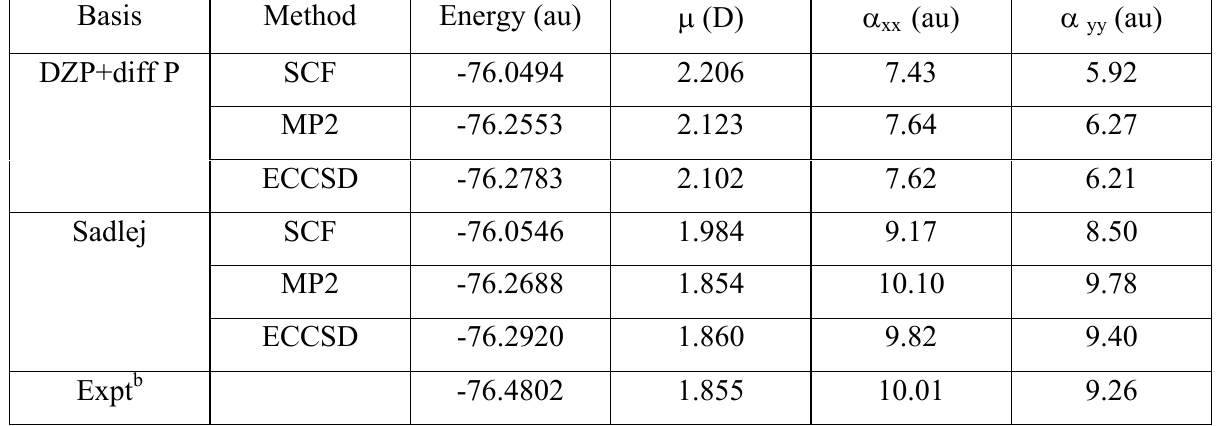
O in different basis sets a 2